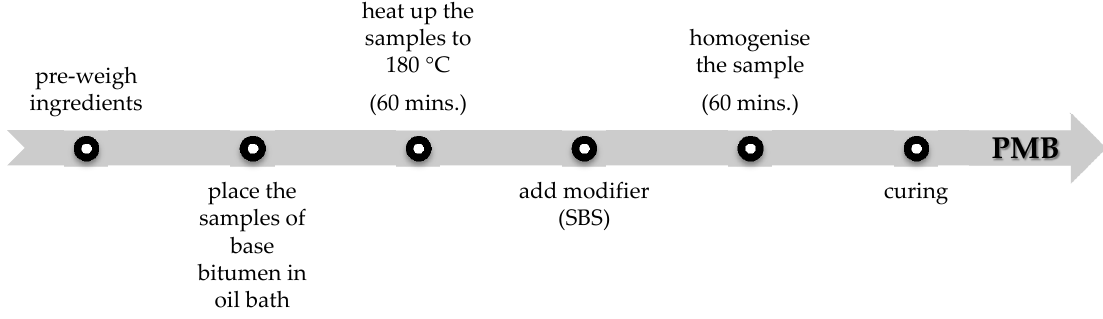
Figure 2. Preparation of lab samples of polymer-modified bitumens.